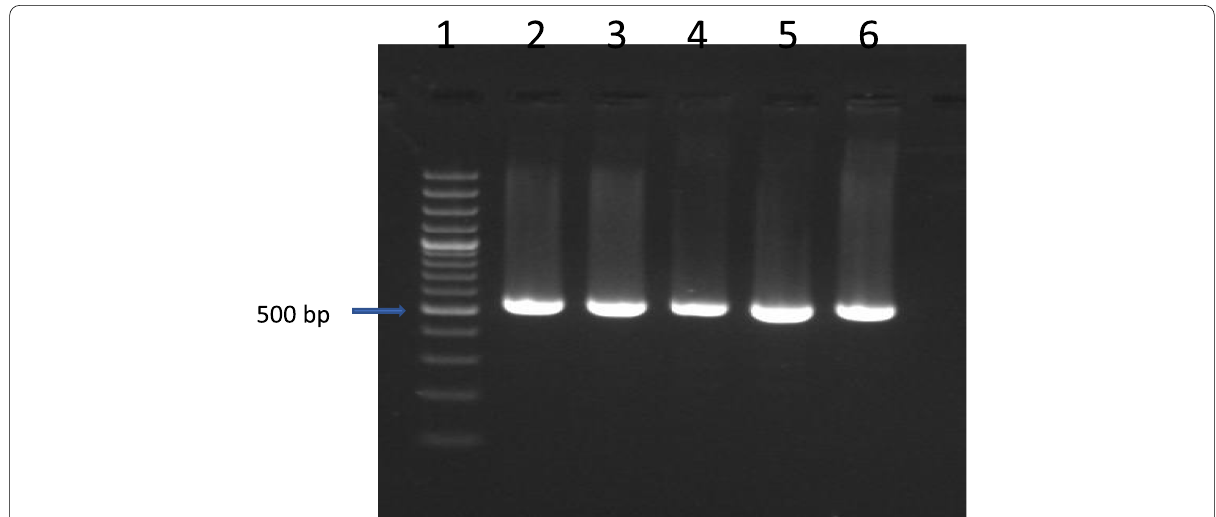
Fig. 1 Electrophoresis of PCR products for camel 16S mtDNA. Lane 1, 100‑bp DNA molecular marker; lanes 2–6, amplified PCR products at 530 bp